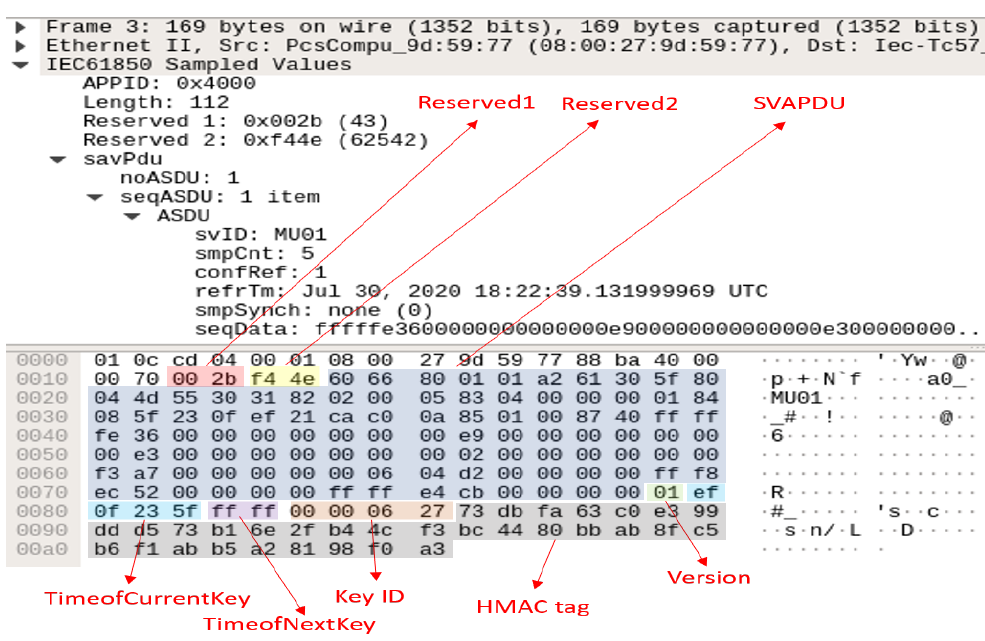
Figure 4. Captured SV packet with